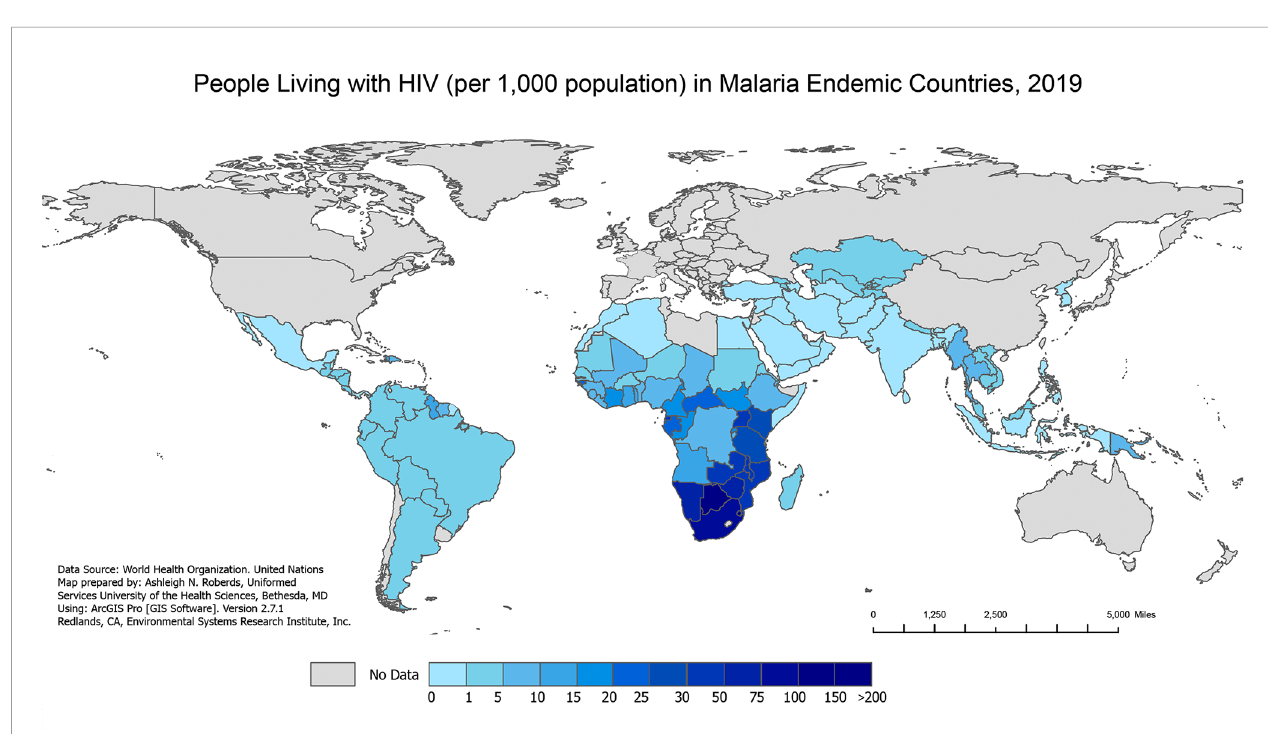
FIGURE 2 | People Living with HIV in Malaria Endemic Countries, 2019. The number of people living with HIV (per 1,000 population) in 2019 in malaria endemic countries from the WHO 2020 World Malaria Report. The 2019 HIV data are extracted from the Joint United Nations Programme on HIV/AIDS (UNAIDS) AIDSinfo data sheet. The 2019 country populations are extracted from the United Nations 2019 World Population Prospects.